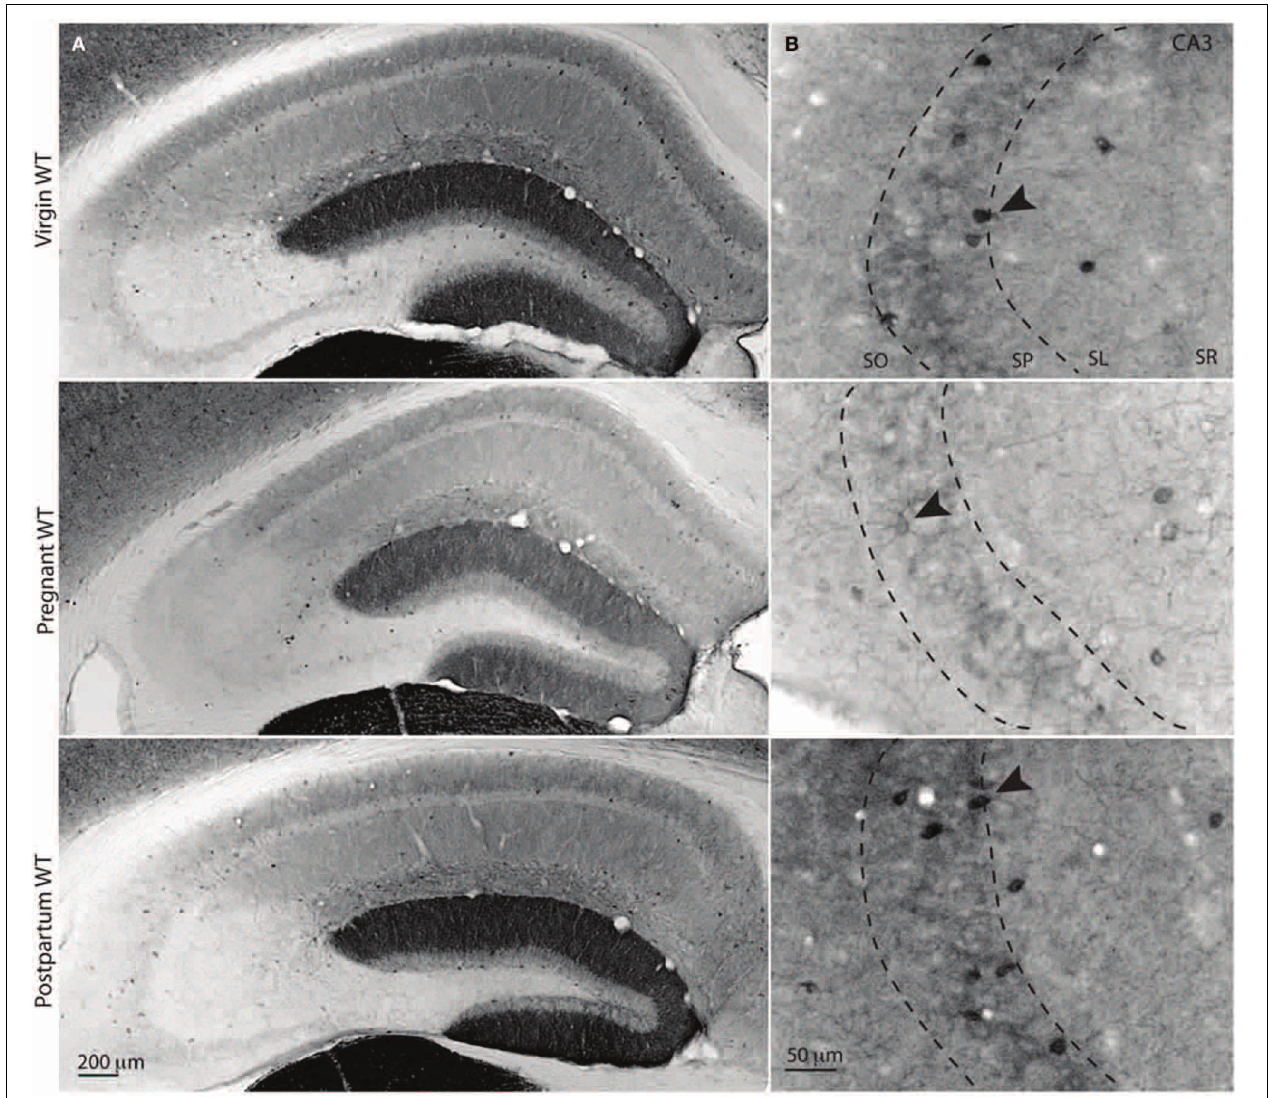
FIGURE 3 | Surface δ -GABA A Rs expression is reduced during pregnancy in CA3 stratum pyramidale interneurons. (A,B) Representative bright-field images of whole hippocampal DAB staining for δ -GABA A Rs in virgin, pregnant and postpartum (48h) WT mice. Surface staining of functionally relevant receptors was obtained by processing tissues under non-permeabilizing conditions. In the hippocampus δ -GABA A Rs are mostly expressed on dentate gyrus granule cell dendrites (forming dentate molecular layer), many hippocampal INs, and CA1 principal cells basal and apical dendrites. (A) Surface δ -GABA A Rs expression is reduced in hippocampal CA1 pyramidal cells and dentate gyrus granule cells, as previously reported, and this is reflected in a lighter staining of the neuropil